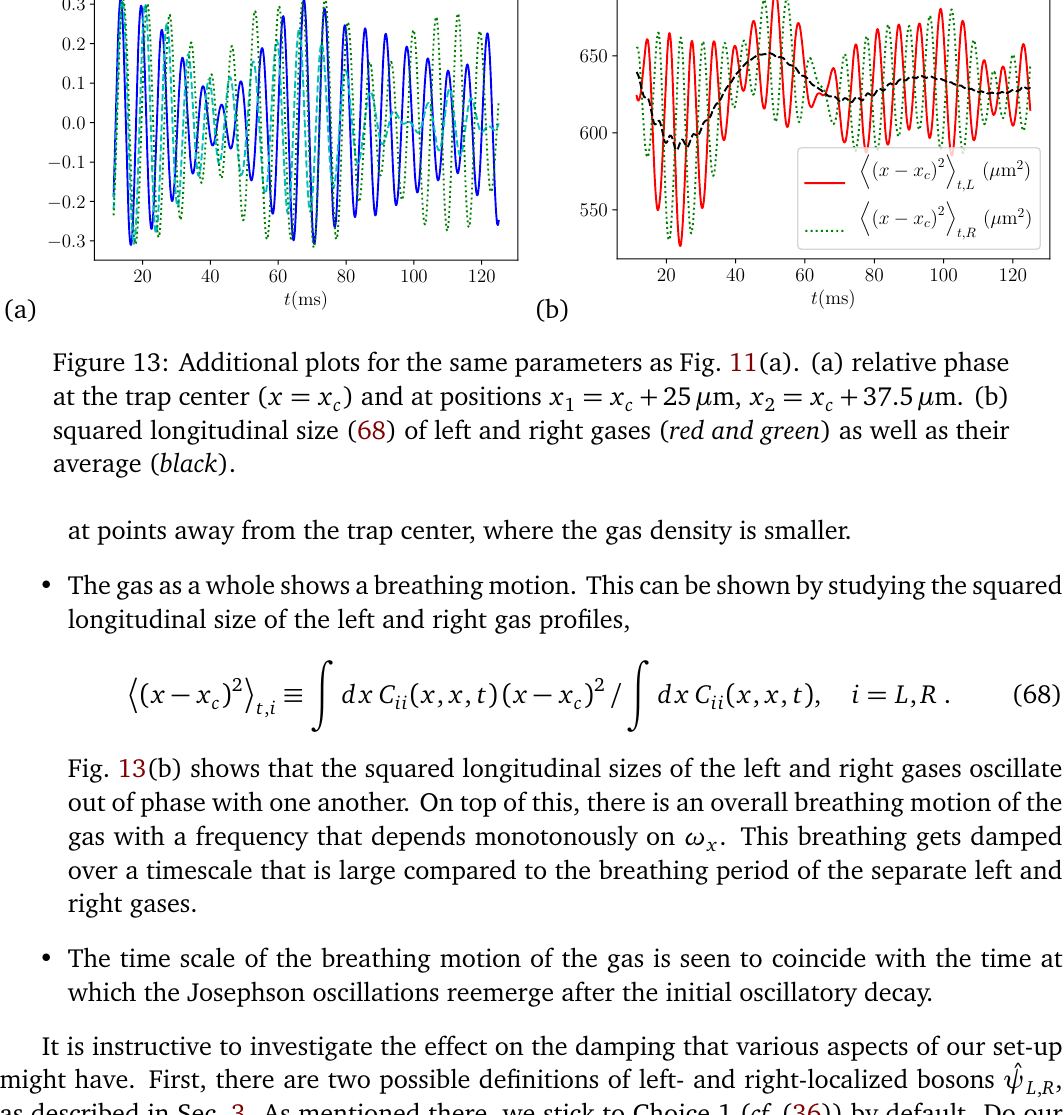
) and at positions x c